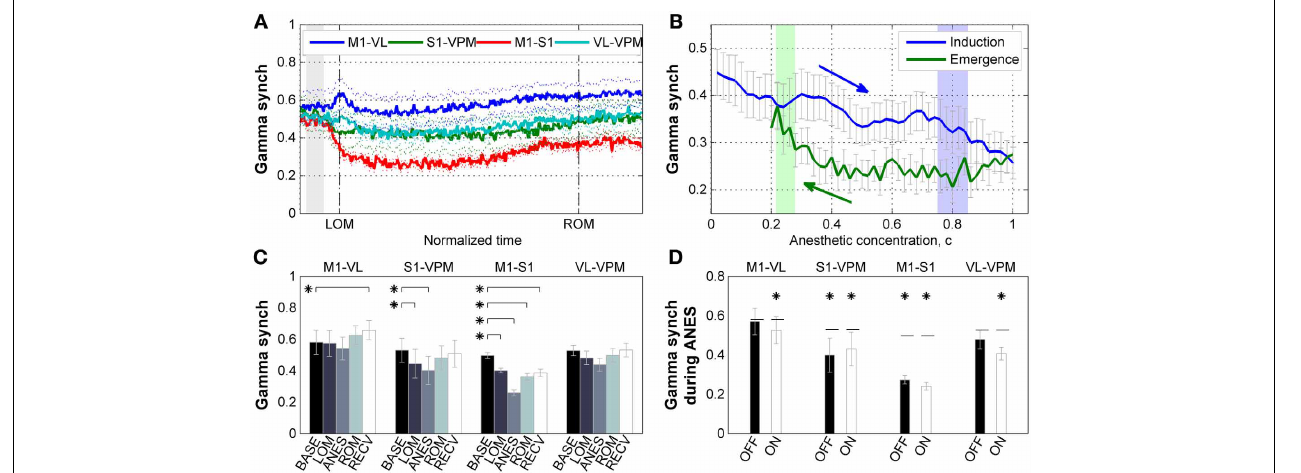
at different brain regions for different behavioral states. Error bars indicate s.e.m. (D) Different behavior of gamma synchrony during anesthesia state depending on the phase of slow oscillation. There was no significant difference between synchrony values during OFF state and ON state of the slow oscillation. Horizontal dashed lines indicate baseline level for each pair. Asterisks indicate significant ( p < 0 . 05, Friedman’s ANOVA test and post-hoc Wilcoxon signed rank test with Bonferroni correction) difference from baseline. Error bars indicate s.e.m. BASE, baseline; LOM, loss of motion; ANES, anesthesia; ROM, recovery of motion; RECV, recovered state. M1, primary motor cortex; S1, primary somatosensory cortex; VL, ventral lateral thalamic nucleus; VPM, ventral posteromedial thalamic